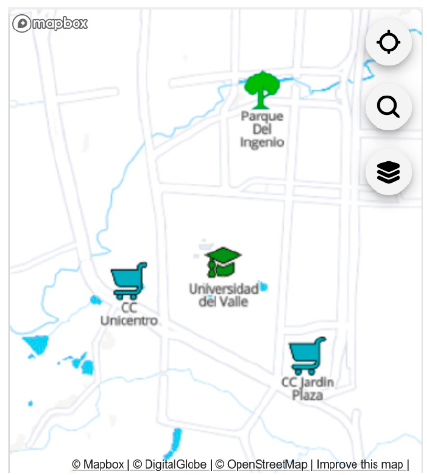
Figure 2. Landmark map.